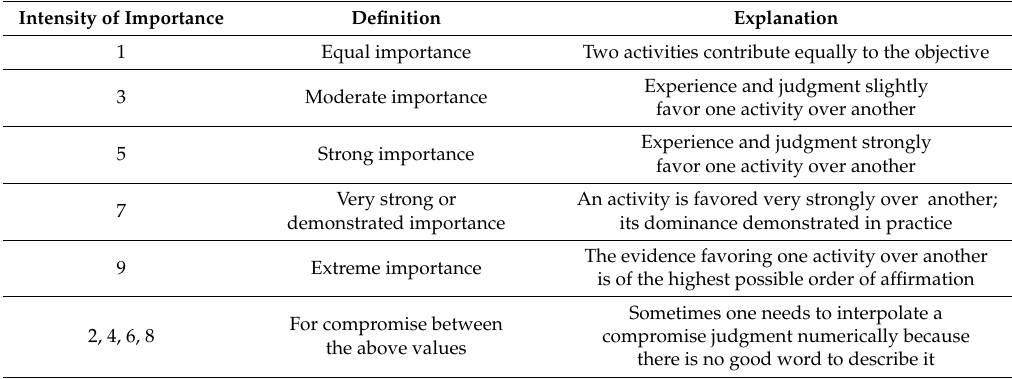
Table 4. Fundamental scale for pairwise comparison to implement AHP technique (after Saaty [34]). Intensity of